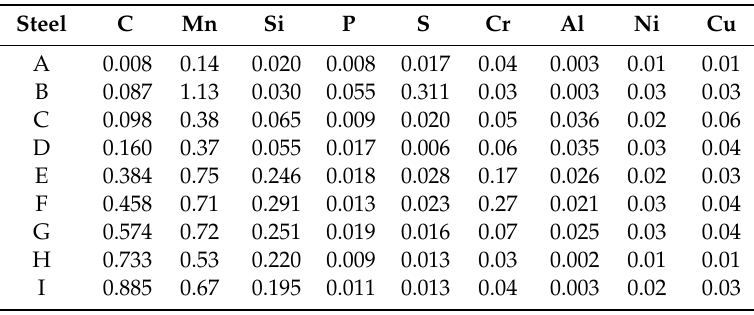
Table 1. Chemical compositions of the investigated steels in